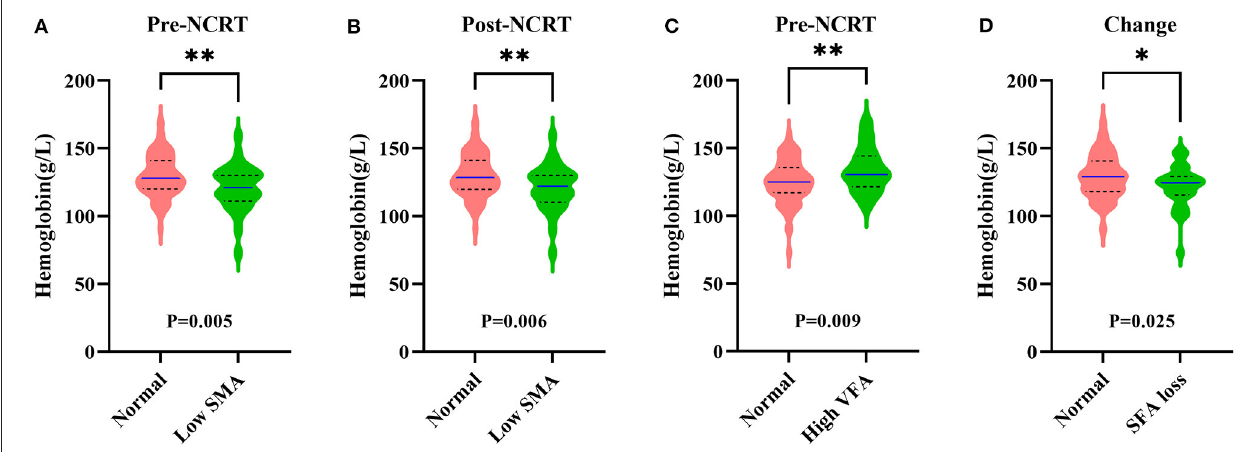
FIGURE 3 | Correlation among hemoglobin and pre-NCRT skeletal muscle area (SMA) (A) , post-NCRT SMA (B) , pre-NCRT visceral fat area (VFA) (C) , subcutaneous fat area (SFA) loss (D) . The *symbol indicates p < 0.05 and **symbol indicates p < 0.01.